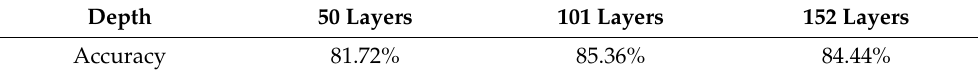
Table 11. The comparison of culm classification performance by deep residual network depth. Depth 50 Layers 101 Layers 152 Layers Accuracy 81.72% 85.36% 84.44%